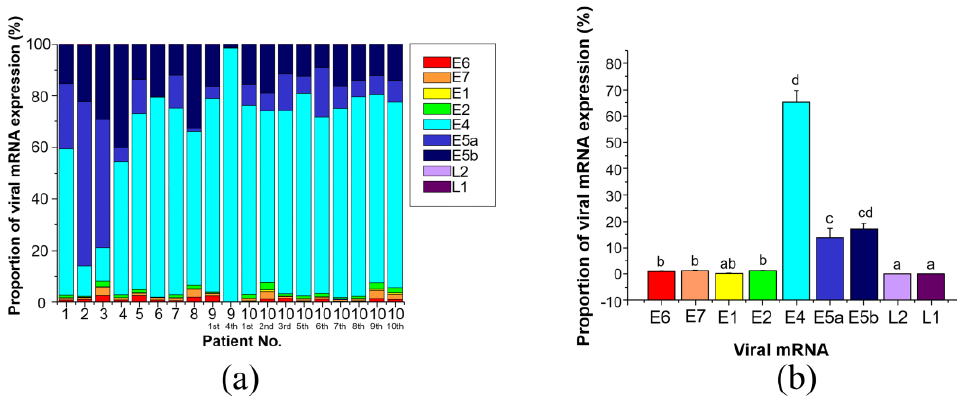
Figure 3. HPV-6 mRNA expression in individual cases and summation of all cases. ( a ) Viral mRNA expression in each case. There were some differences in the proportion of E4 , E5a , and E5b expression. However, these 3 mRNAs were predominant compared with the other mRNAs examined. ( b ) Proportion of mRNA expression. E4 was the most prevalent gene among the 9 viral mRNAs.